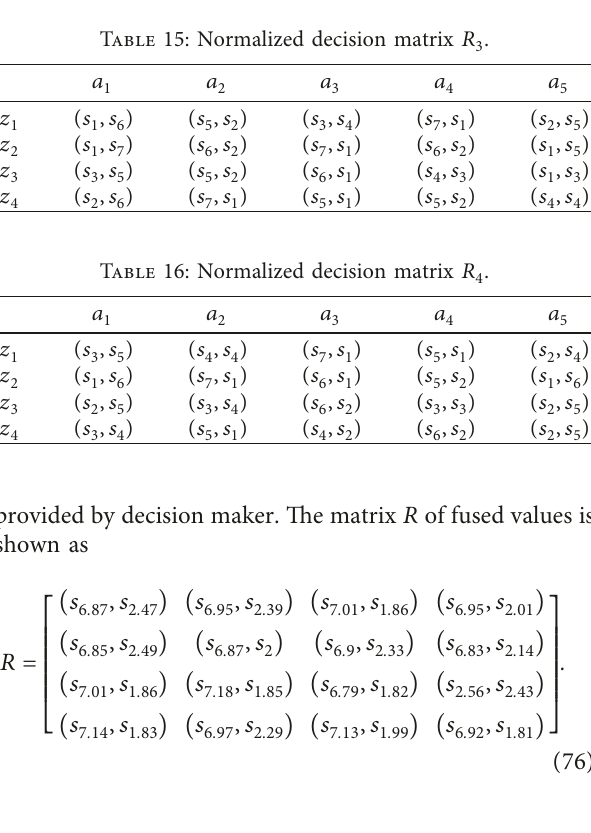
Table 14: Normalized decision matrix R a 1